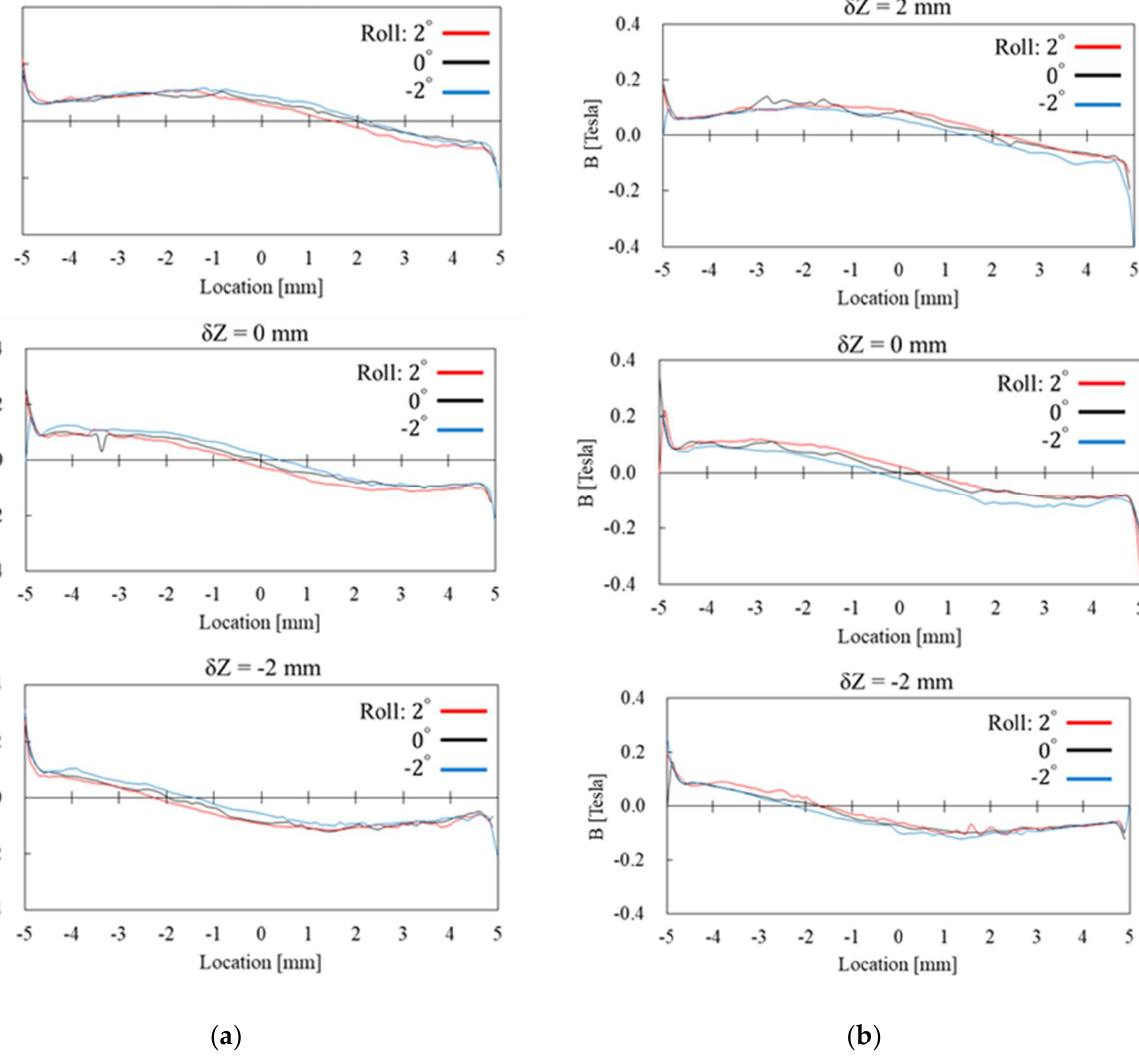
Figure 11. Simulation results of the radial magnetic flux density through the Wiegand wire with Y being set at ( a ) −0.1 mm and ( b ) 0.1 mm, respectively.